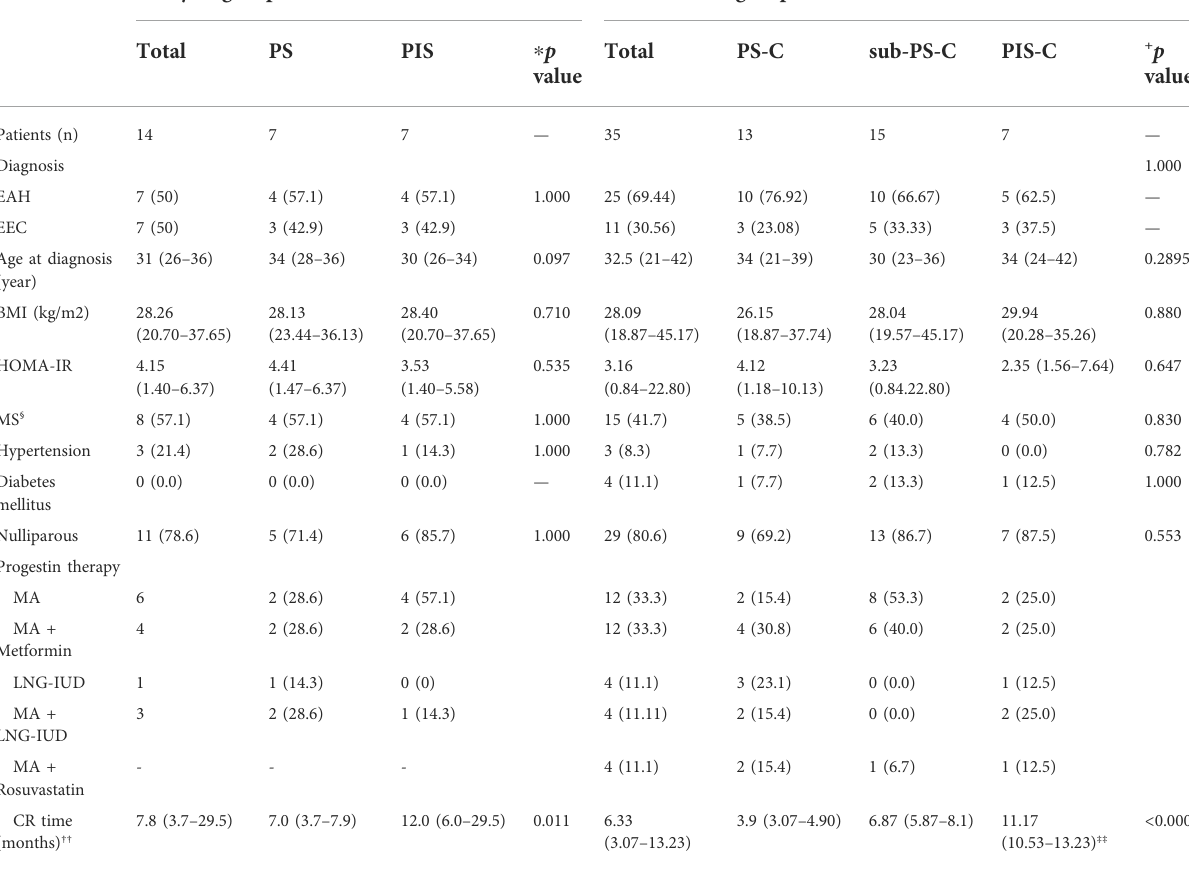
TABLE 1 General characteristics of the study